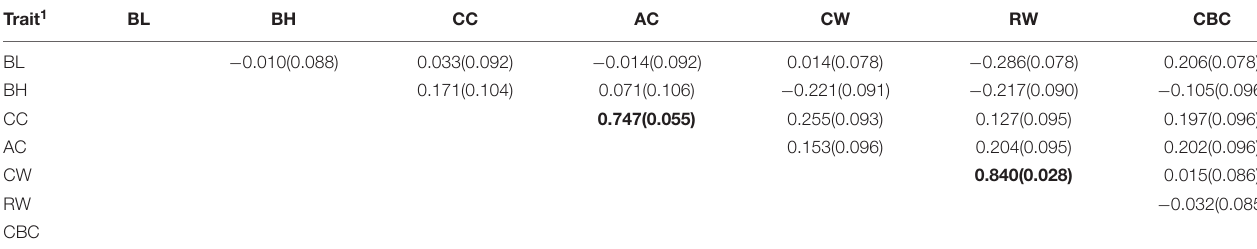
TABLE 2 | Genetic correlations between seven body size traits. Trait